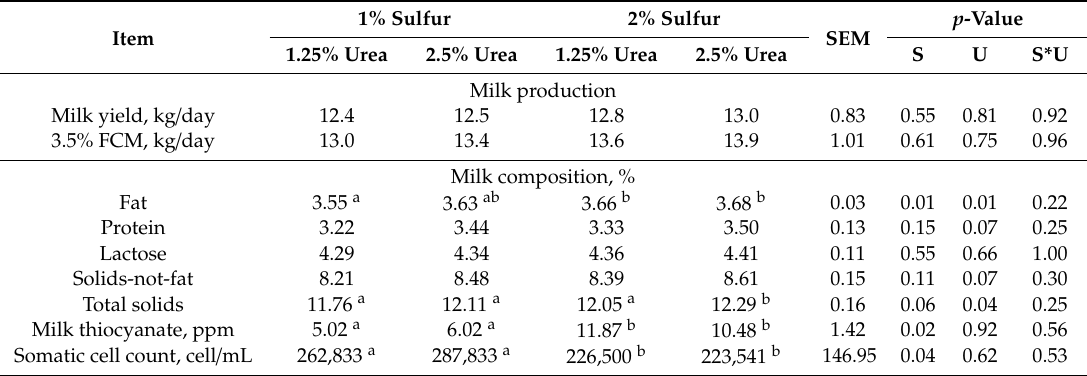
Table 6. E ff ect of fermented total mixed ration on milk production and chemical